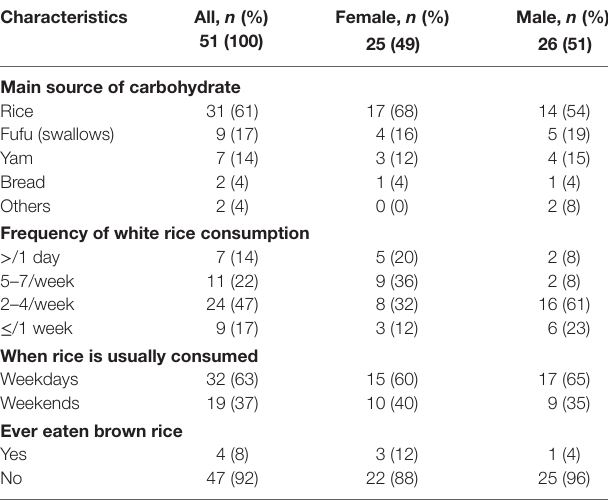
TaBle 3 | Dietary characteristics of the study participants.